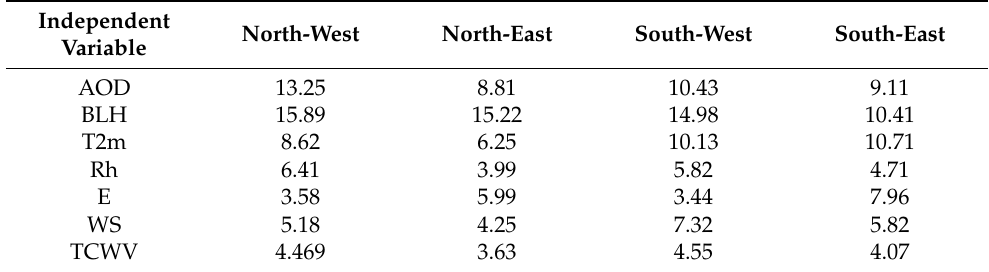
Table 3. The effects (%) of AOD and the most important meteorological variables on PM 2.5 estimations in the four chosen parts of our study